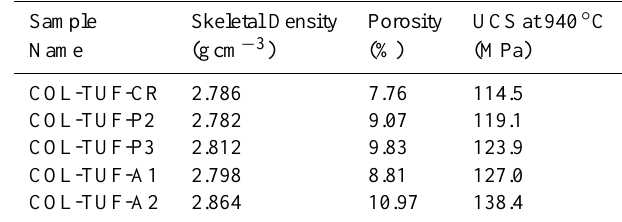
Table 1. Physical properties of the sample